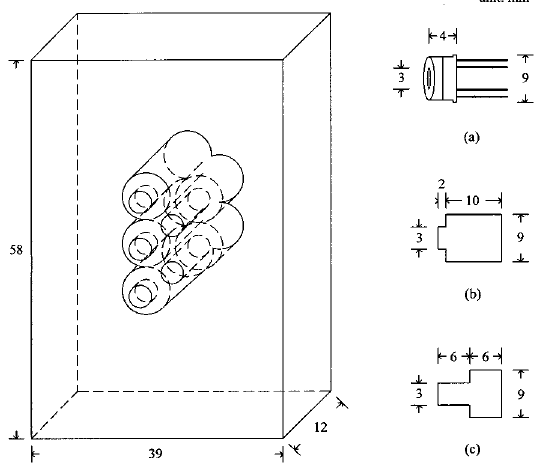
Figure 3. A schematic diagram of the sensor holder, and dimensions of the sensor (a), left-line hole (b), and right-line hole